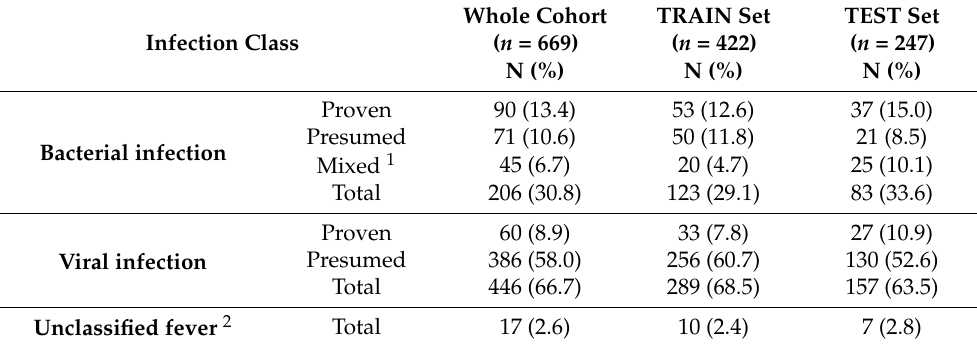
Table 1. Infection classification in the whole, training (TRAIN), and validation (TEST)